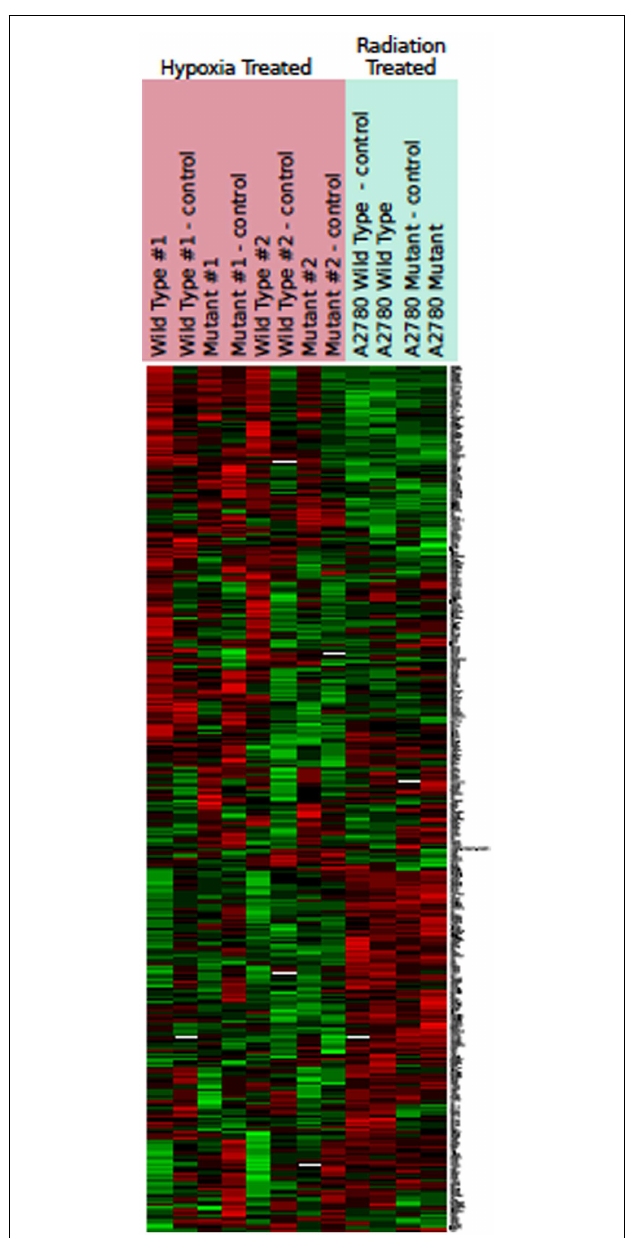
FIGURE 4 | Heat map representing color-coded expression of differentially expressed genes under hypoxic conditions and after radiation . Numbers indicate multiple replicates performed for each sample. Three genes showed statistically significant upregulation by hypoxia. No change in gene expression was noted after